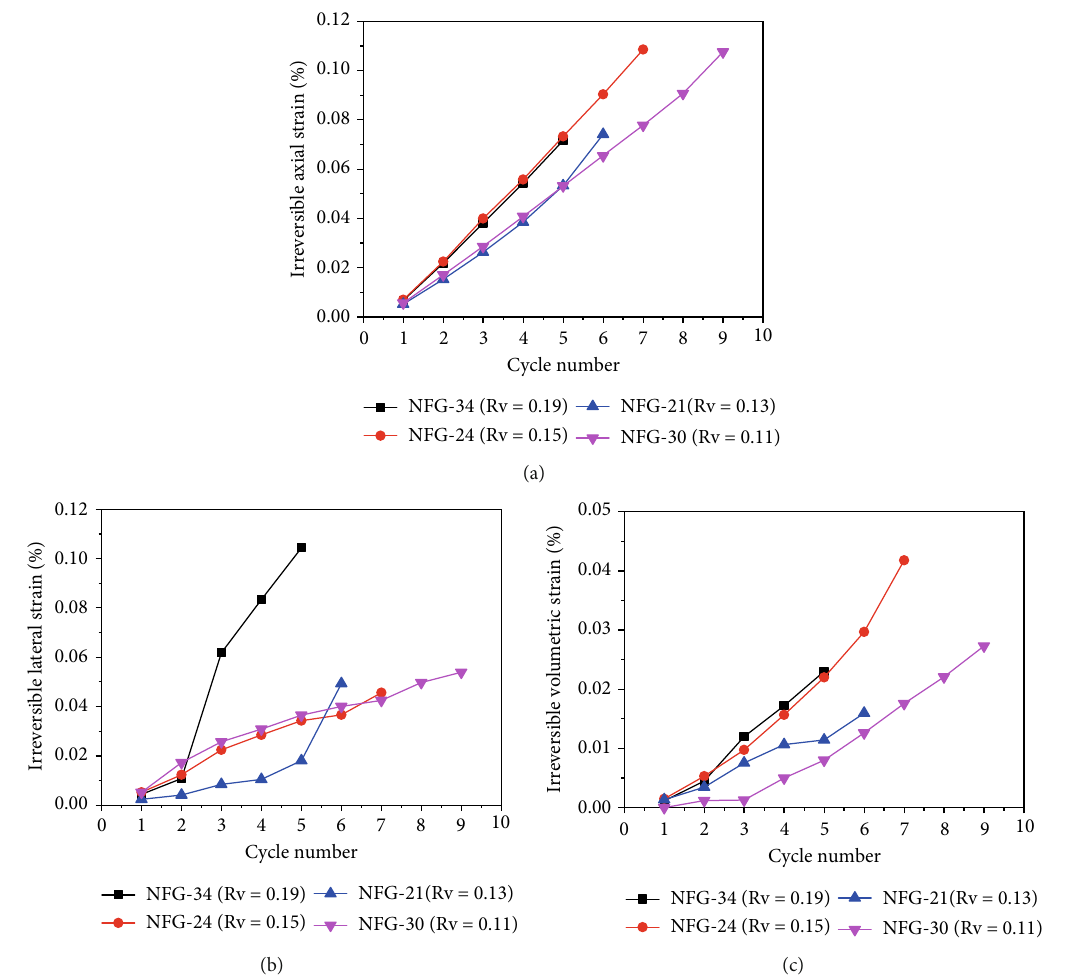
Figure 11: Plots of the irreversible deformation against the number of loading cycle. (a – c) Evolution of the axial, lateral, and volumetric irreversible strains with cycle loading number, respectively.